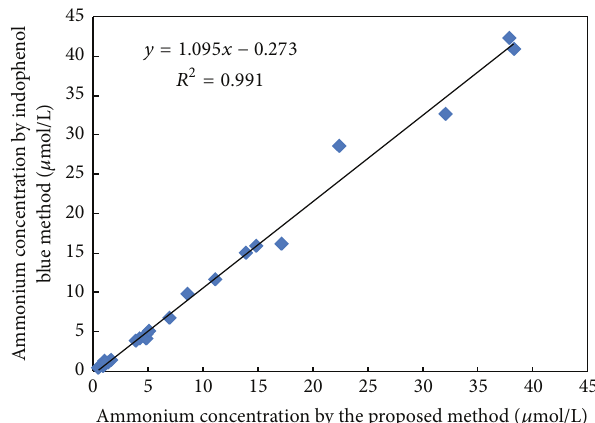
Figure 5: Intercomparison data with indophenol blue method.